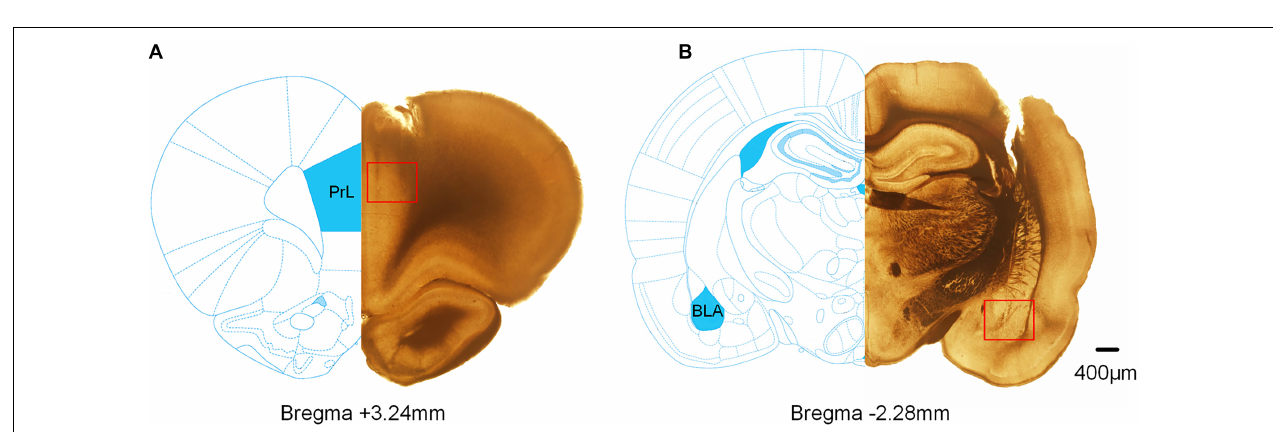
FIGURE 7 | Comparison of the average theta IF of the mPFC-BLA and BLA-mPFC in exploratory behaviors between the control and depression groups. (A) Comparison of the average theta IF of mPFC-BLA in the peripheral zone. (B) Comparison of the average theta IF of the mPFC-BLA in the central zone. (C) Comparison of the average theta IF of the mPFC-BLA from the peripheral to the central zone. (D) Comparison of the average theta IF of the BLA-mPFC in the peripheral zone. (E) Comparison of the average theta IF of the BLA-mPFC in the central zone. (F) Comparison of the average theta IF of the BLA-mPFC from the peripheral to the central zone. Error bars indicate SEM. Independent sample t -test, ns p > 0.05 no significance, *** p < 0.001.